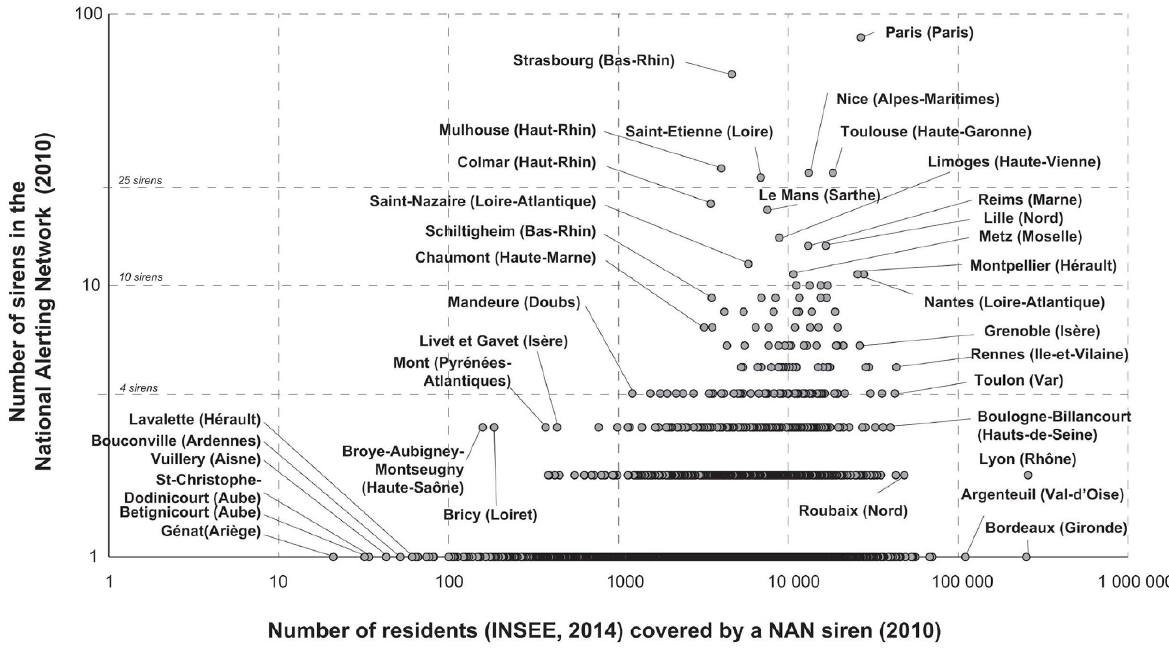
Figure 3. Number of NAN sirens by municipalities and average number of inhabitants served by each siren.